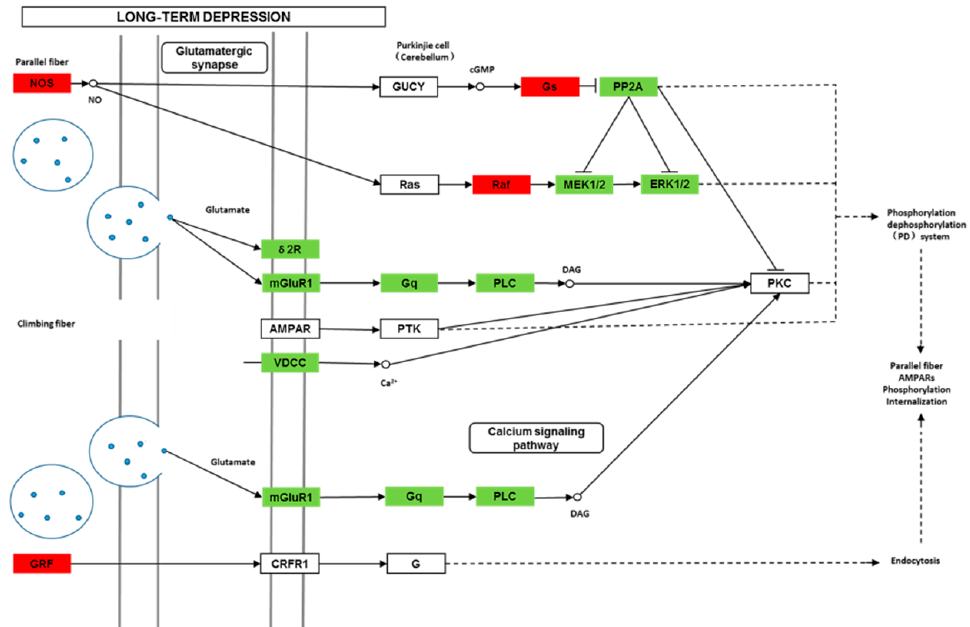
Figure 7. Differentially expressed genes in the long-term depression between mandarin fish in the control group (CG) and the learning group (LG) from a transcriptome analysis. The colors of rectangles were shaded according to the different expression (red: The mRNA expression levels of fish in Group LG were significantly higher than those in Group CG (FDR ≤ 0.001, the absolute value of log2 (Ratio) ≥ 1); green: The mRNA expression levels of fish in Group LG were significantly lower than those in Group CG (FDR ≤ 0.001, the absolute value of log2 (Ratio) ≥ 1)).